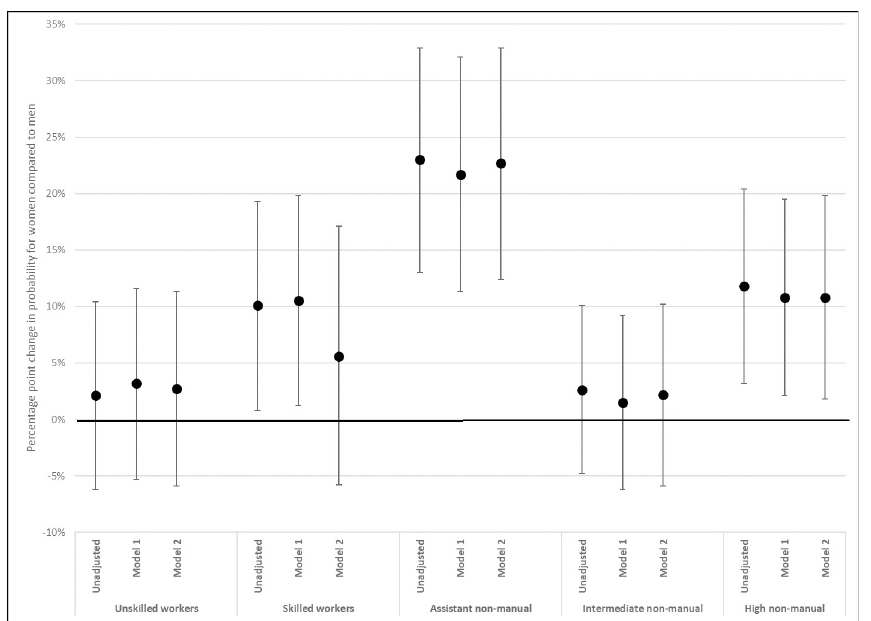
Fig 6. Gender differences in probability of musculoskeletal pain, by class. Coefficients from class-separate LPM. Coefficients (for woman = 1) interpreted as percentage point change in probability for musculoskeletal pain. From class-separate linear probability models, with 95% confidence intervals (Table G in S4 Appendix). Unadjusted model regresses musculoskeletal pain on gender, separately by class. Stepwise adjustment for physical working conditions (Model 1) and psychosocial working conditions (Model 2). Both unadjusted and adjusted models are controlled for age and age^2.